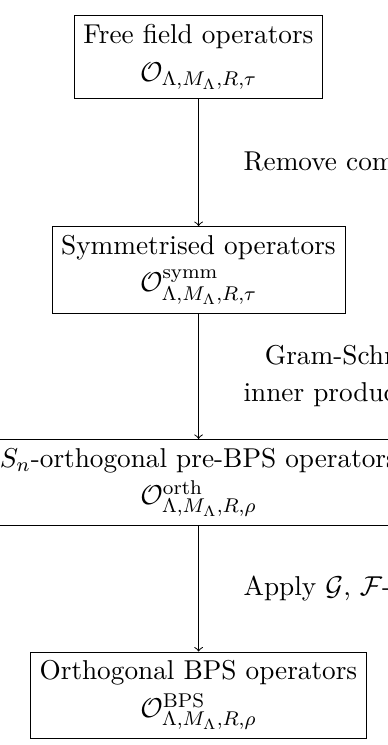
Figure 4 . Outline of the alternative algorithm of this section. Our numerical calculations suggest that O BPS agrees (up to a choice of multiplicity basis) with the operators S BPS Λ ,M Λ ,R,ρ from the algorithm in figure